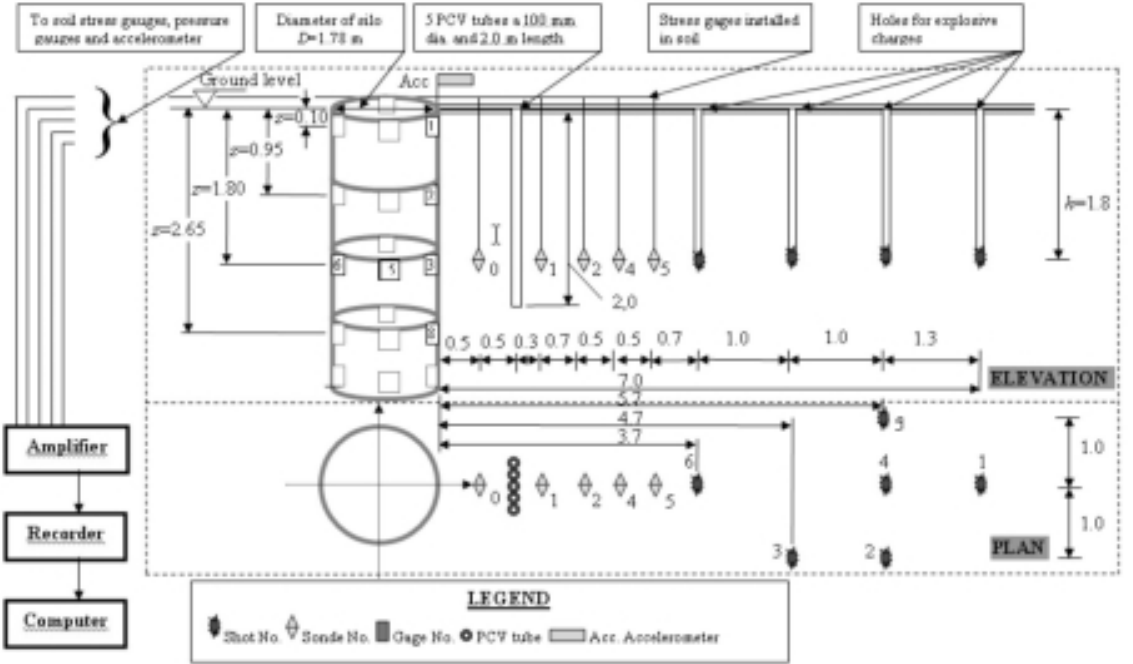
Fig. 5. Sequence of explosions and arrangements of soil stress gages and soil pressure gages.